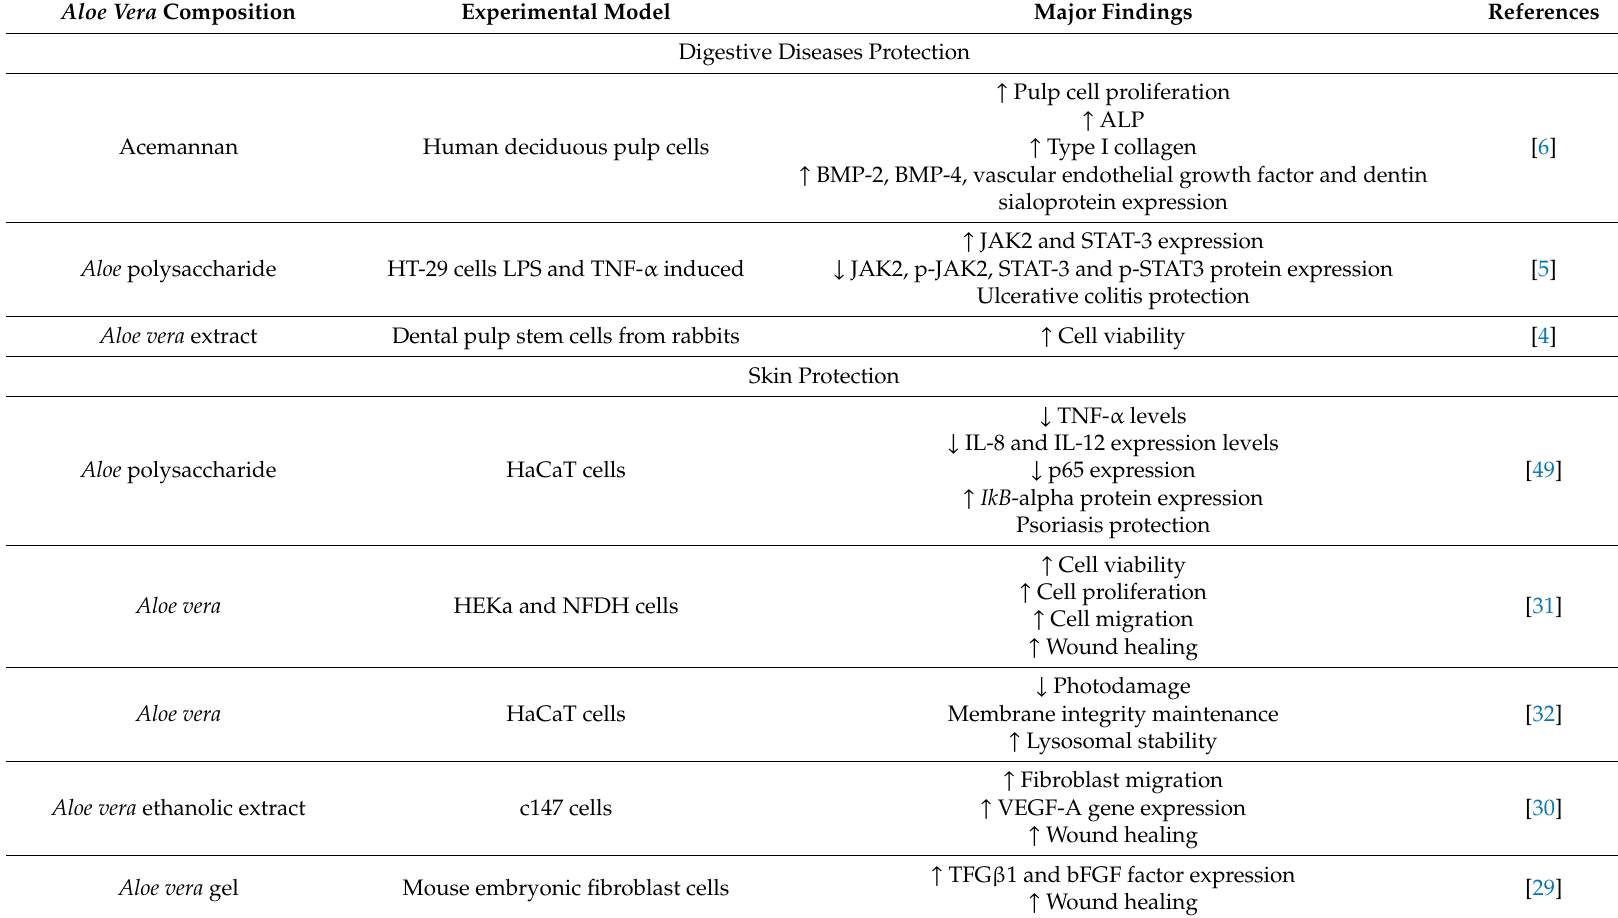
Table 1. In vitro pharmacological studies for Aloe vera